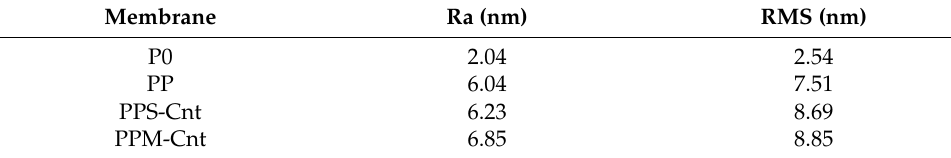
Figure 3. Membrane surface roughness analyzed by AFM: ( a ) P0, ( b ) PP, ( c ) PPS-Cnt, and ( d ) PPM-Cnt. Table 2. Roughness parameter of the ultimate membranes.